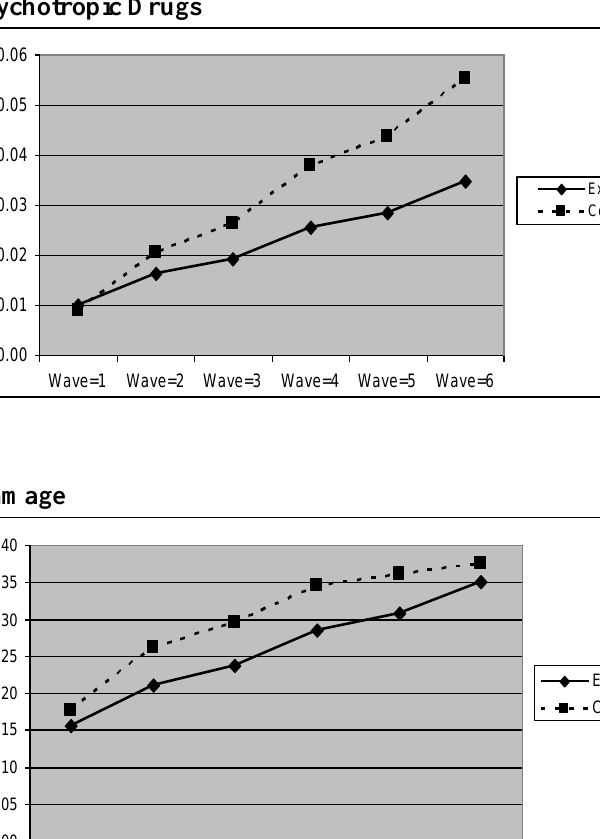
FIGURE 17 . Growth trajectories of the experimental group (Tier 1 participants who perceived the program as effective) and control group using the item score of damaging other’s properties as the outcome indicator.